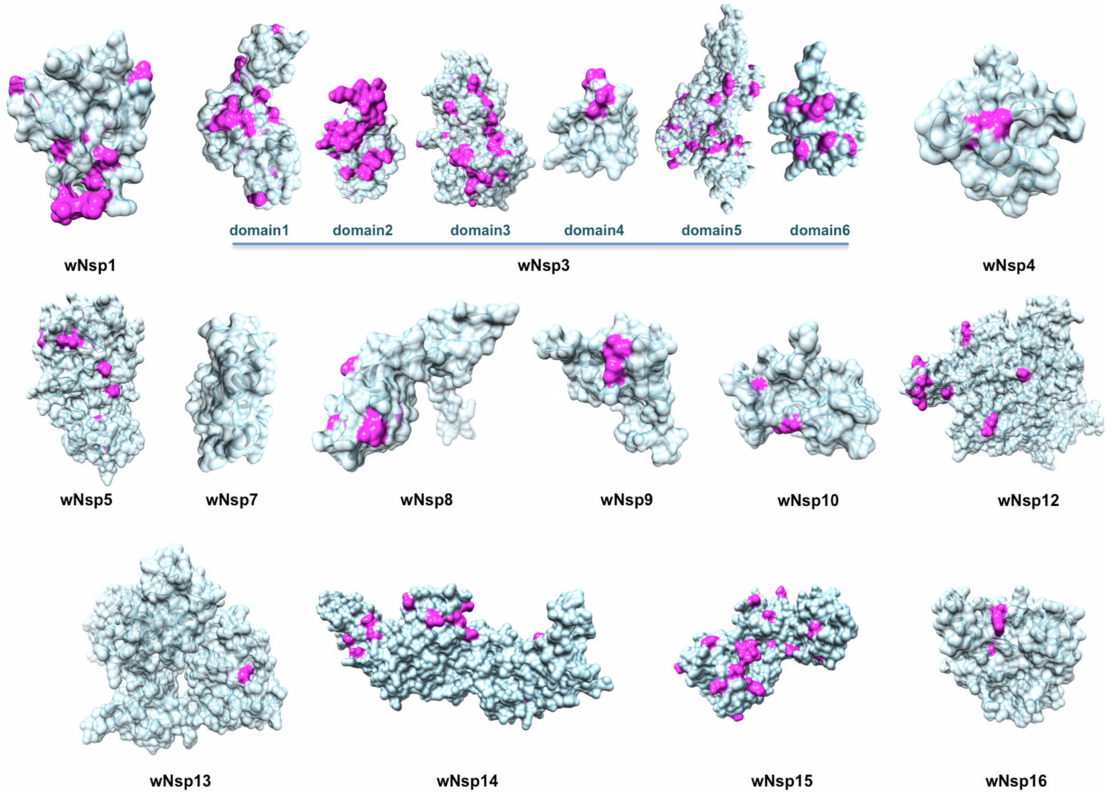
Figure 2. Structurally characterized non-structural proteins of SARS-CoV-2. Highlighted in pink are mutations found when aligning the proteins against their homologs from the closest related coronaviruses: human SARS-CoV, bat coronavirus BtCoV, and another bat betacoronavirus BtRf-BetaCoV. The structurally resolved part of wNsp7 shares 100% sequence identity to its homolog.